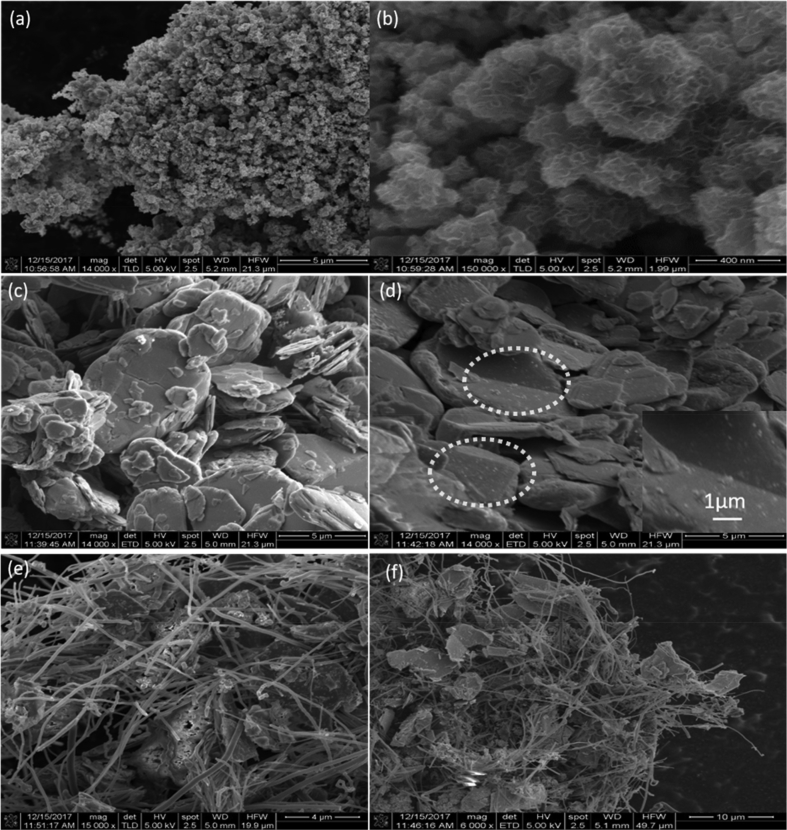
SEM images of (a,b) MoS2, (c,d) MoS2/NiO NPs and (e,f) MoS2/NiO NPs/MWCNT nanocomposite.